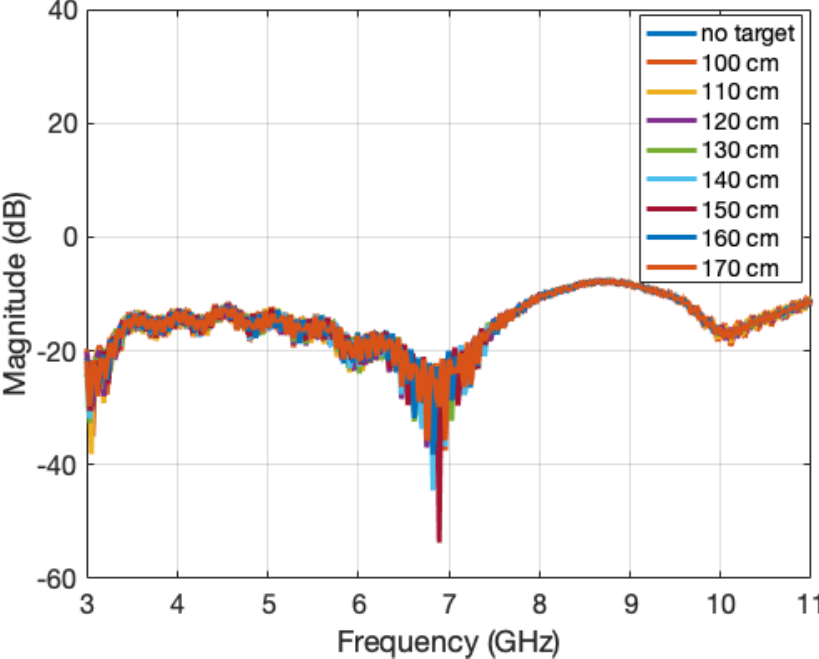
Figure 6. Input reflection coefficient of the horn antenna measured at eight distances far away from the